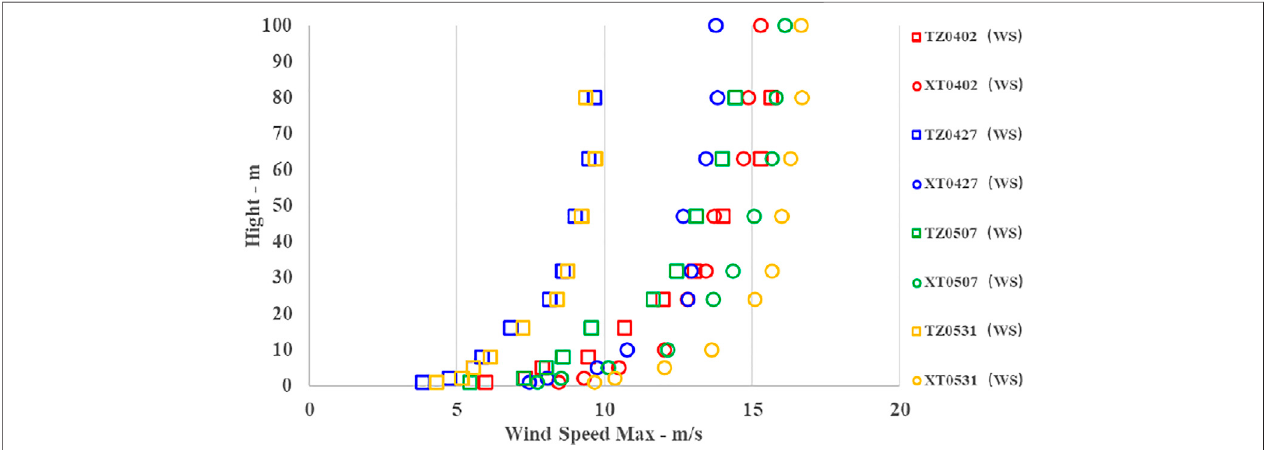
FIGURE 9 | Variation in the maximum wind speed with height during four typical dust storm processes in XT and TZ.